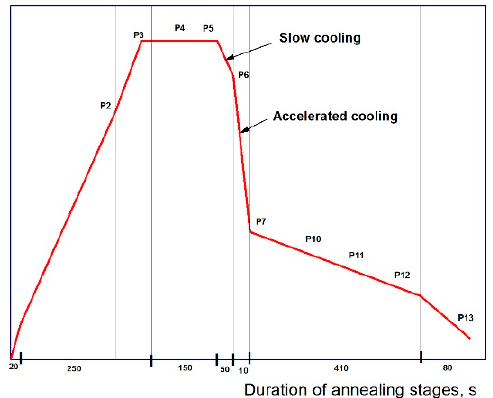
Figure 1. Scheme of heat treatment of cold-rolled steels in a continuous annealing unit (CAU): Pi—strip temperatures at the exit from the zones of heating sections (P2, P3), holding (P4, P5), slow cooling (P6), accelerated cooling (P7), overaging (P10, P11, P12) and final cooling (P13).